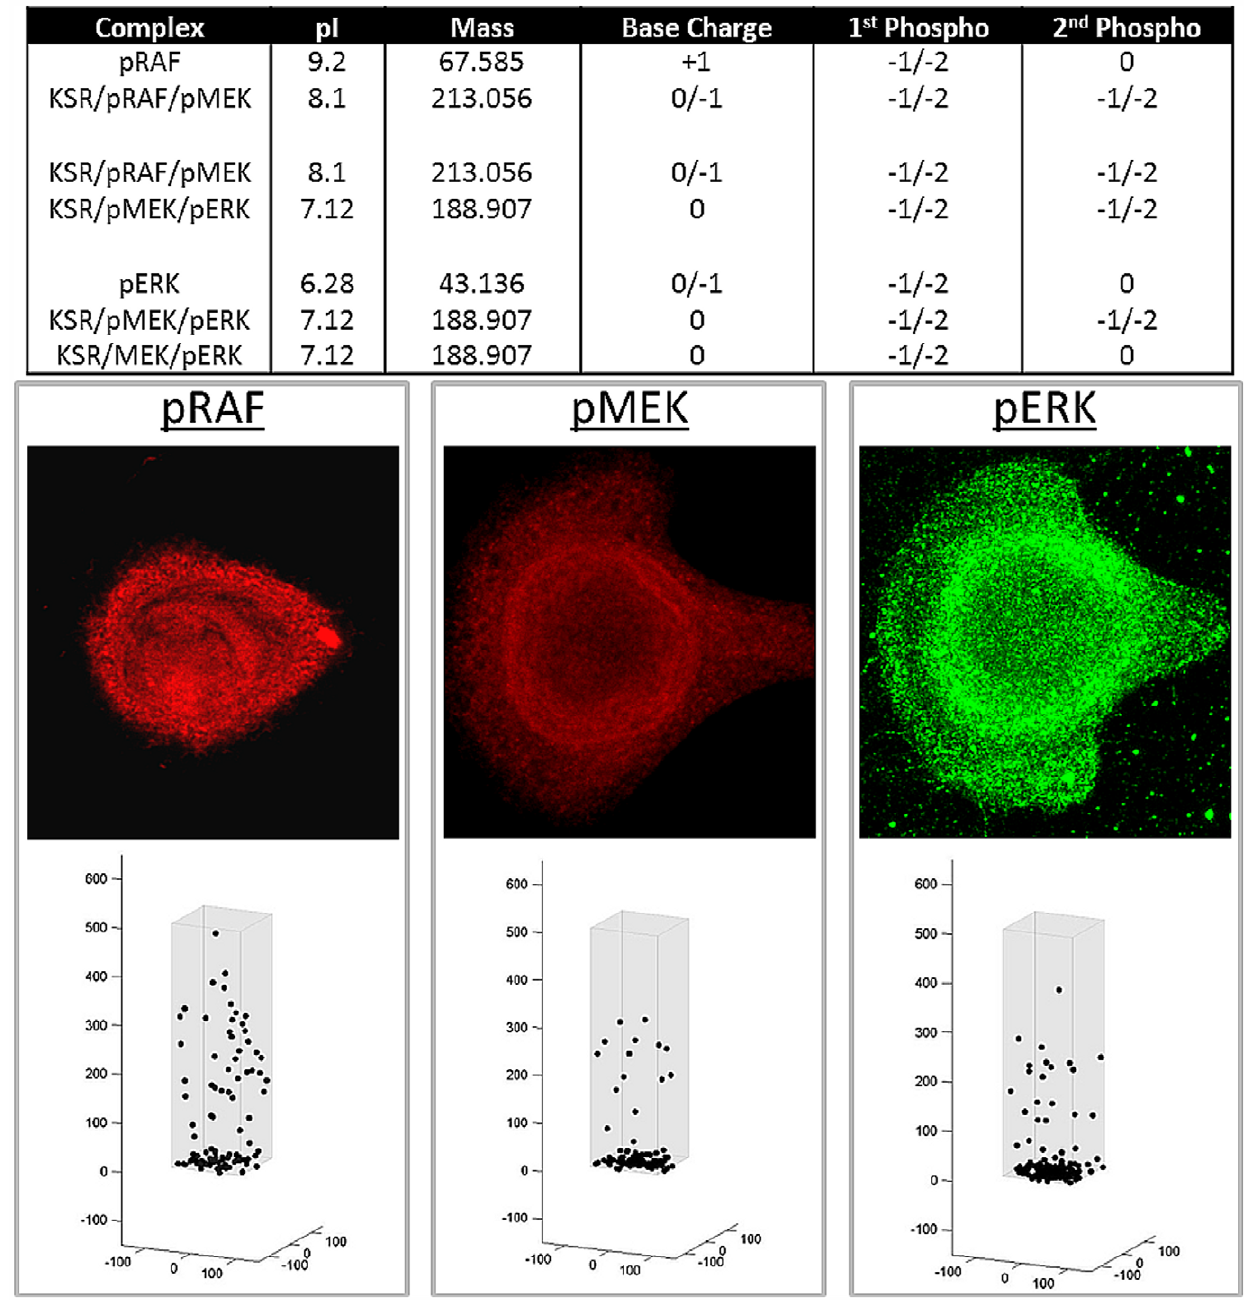
Figure 6. Simulations of steady state distribution of phosphorylated MAPK proteins in culture conditions with continuous presence of EGF. As in Figure 5, the model assumes the presence of scaffolding proteins KSR1 as outlined in the text. Top panel represents the physical characteristics of pRAF, pMEK and pERK both free and bound to KSR1 used in the computer simulations. Lower panels represent predicted steady state distribution of pRAF, pMEK, and pERK in normal cells assuming continuous presence of ligand at the cell membrane and assuming the presence of scaffolding protein KSR1. Middle panels are actual distribution observed in HMEK cells in culture using CYTOO chips so that every cell maintains the same shape. Arrows on the left middle panel denote the approximate location of the CM.